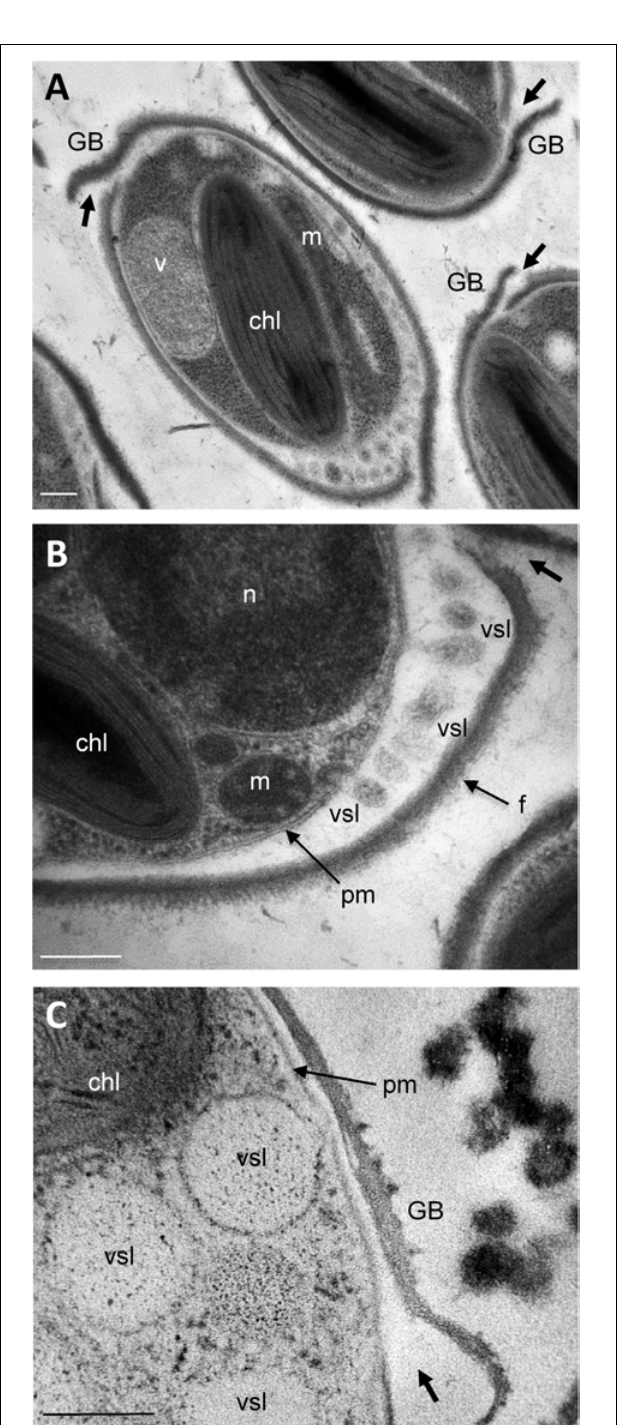
FIGURE 8 | Ultrastructural characterization of the release site of secretory vesicles in P. tricornutum oval morphotype. Transmission Electron micrographs of Pt3 Phaeodactylum tricornutum oval morphotype illustrating the secretion through vesicles. (A) Whole view of the oval cell. (B) Magnification in the interspace between the plasma membrane and the frustule where secretory vesicles are accumulated. (C) Secretory vesicles nearby the girdle band. chl: plastid; GB: girdle band; m: mitochondria; n: nucleus; pm: plasma membrane; f: frustule; vsl: secretory vesicles v: vacuole. Bars, 0.2 µ